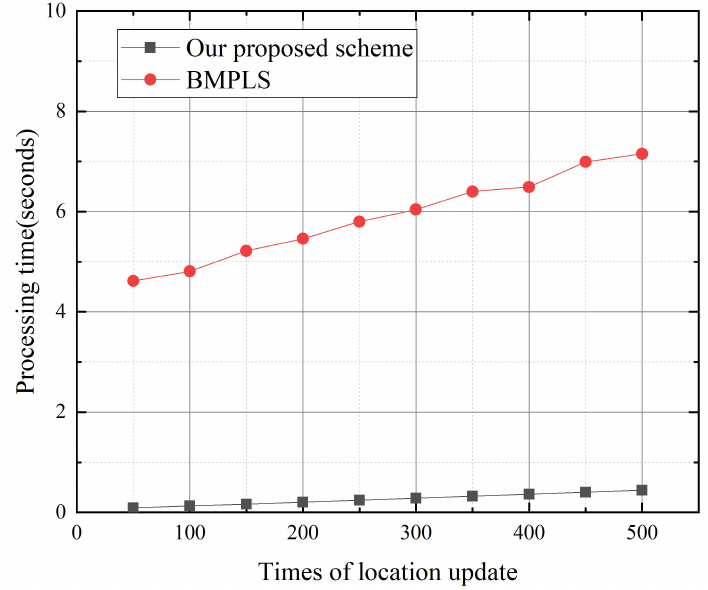
Figure 12. Computation overhead of LP